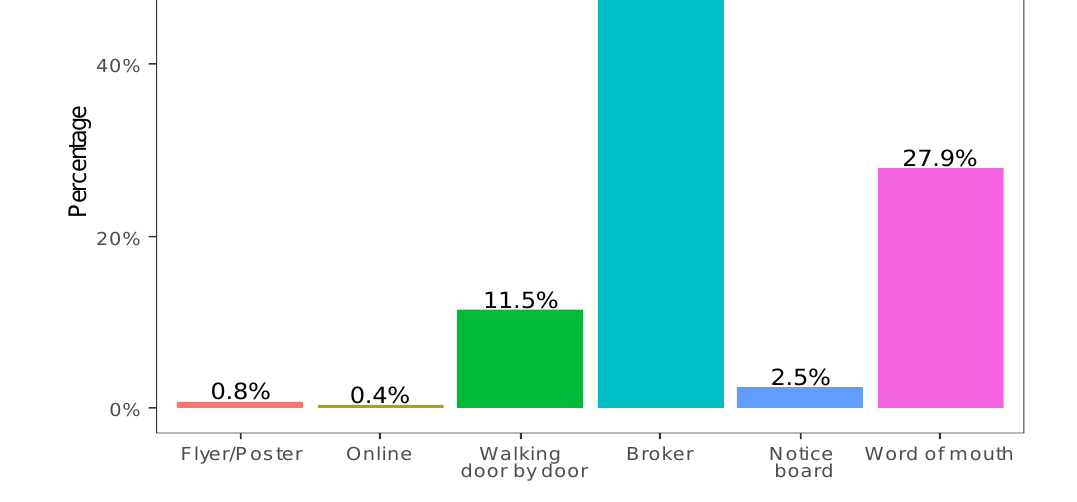
Figure 5. Accommodation Searching Methods